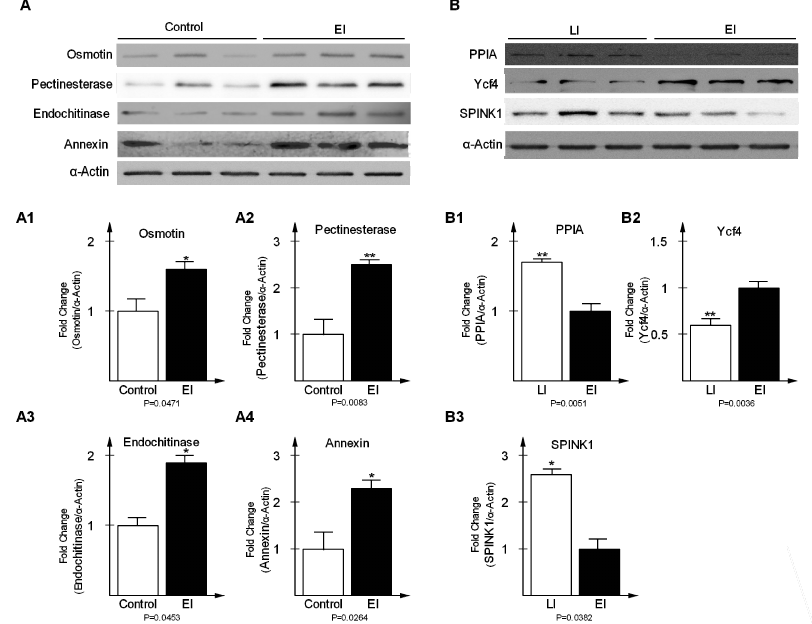
Figure 6. Western blot analysis of differentially expressed proteins at early disease stage ( A ) and late disease stage ( B ). Expression levels of Osmotin (fold change = 1.62, p = 0.00471), Pectinesterase (fold change = 2.53, p = 0.0083), Endochitinase (fold change = 1.94, p = 0.0453) and Annexin (fold change = 2.37, p = 0.0264) were significantly increased in EI relative to Control ( A1 , A2 , A3 , A4 ); PPIA (fold change = 1.74, p = 0.0051) and SPINK1 (fold change = 2.63, p = 0.0382) were significantly increased in LI relative to EI ( B1 , B3 ); Ycf4 (fold change = − 1.67, p = 0.0036) was significantly decreased in LI relative to EI and ( B2 ). Potato actin represented loading control.